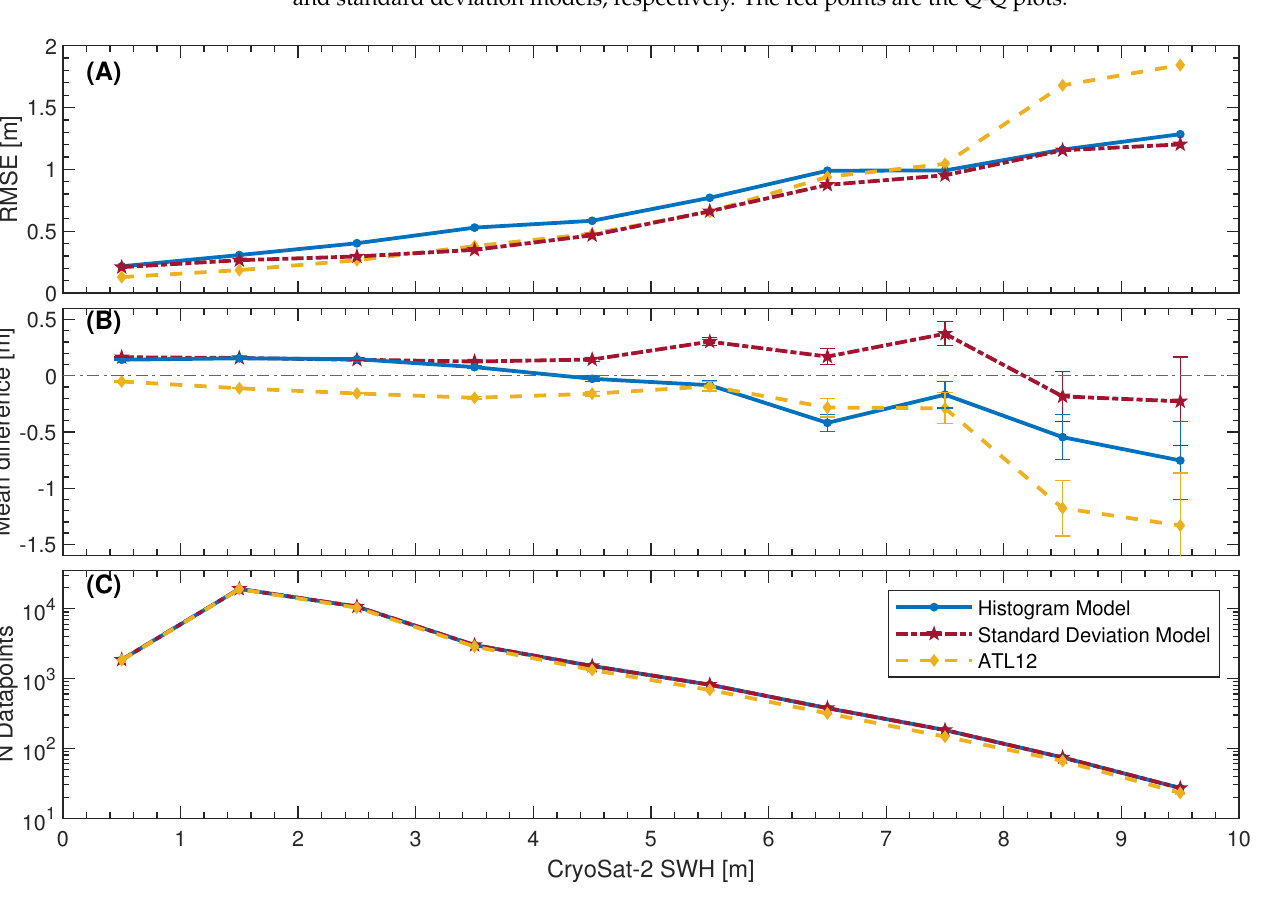
Figure 7. Behavior of the three models compared to CryoSat-2 for increasing SWHs. ( A ) Root mean squared error for each model for increasing SWHs. ( B ) Mean differences between the model SWHs and SWHs determined by CryoSat-2, with 95% confidence intervals at each point determined from the model samples. ( C ) Number of data points at each